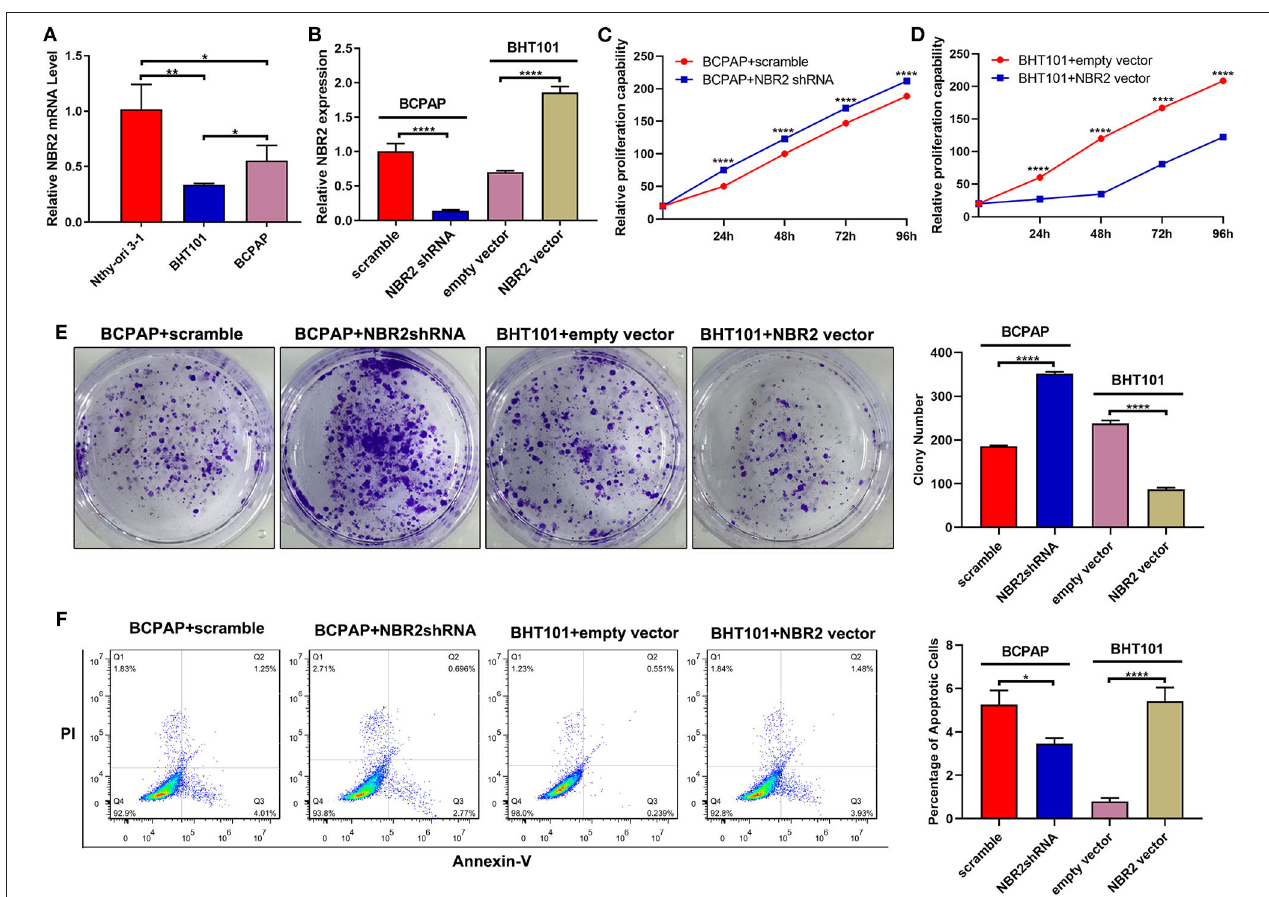
FIGURE 2 | Altered NBR2 expression modulates the proliferation, clonogenicity, and apoptosis of TC cells. (A) The NBR2 expression in non-tumor Nthy-ori3-1, TC BCPAP, and BHT101 cells was analyzed by qRT-PCR. (B) Altered NBR2 expression was demonstrated in TC cells. (C,D) Altered NBR2 expression changed the proliferation of TC cells, determined by CCK-8 assays. (E) The colony formation. (F) Flow cytometry analysis of apoptotic cells. Data are expressed as the mean ± SD of each group of cells from three separate experiments. * P < 0.05; ** P < 0.01; **** P < 0.001.